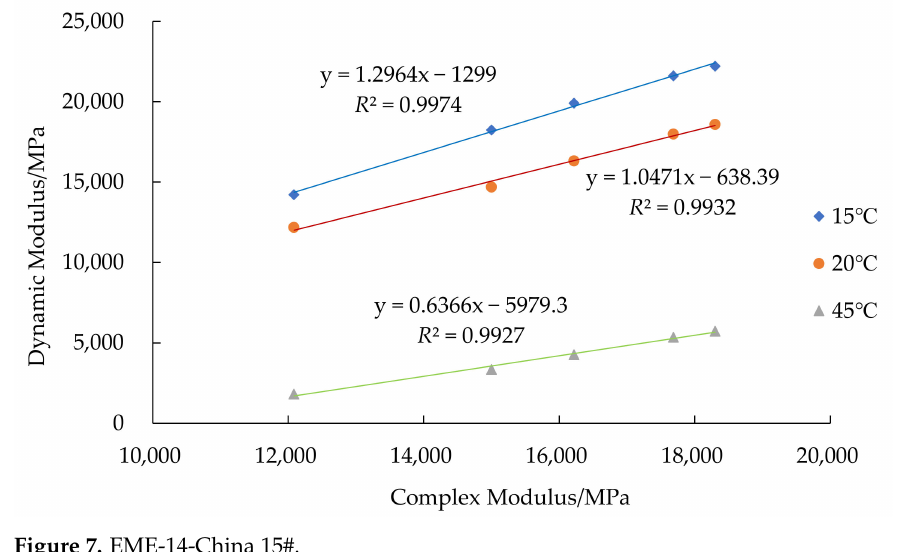
Figure 7. EME-14-China 15#.